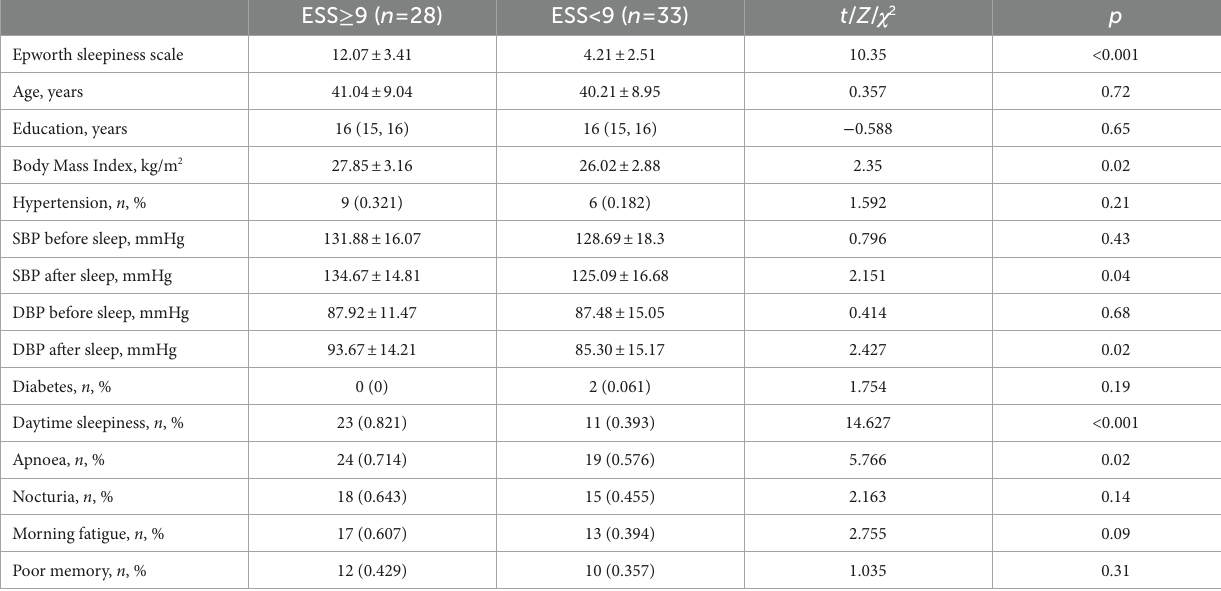
TABLE 1 Demographic and clinical characteristics of OSA